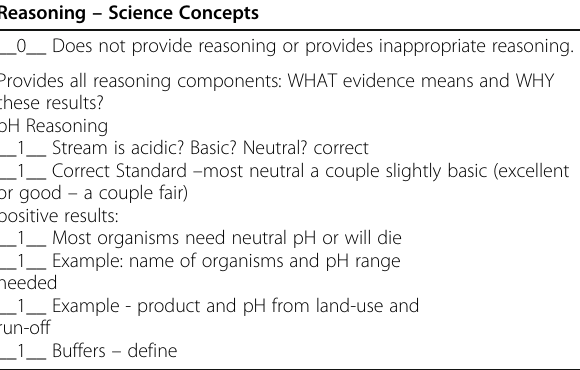
Table 3 Translation of pH concepts into statements that became the pH portion of the rubric Reasoning – Science